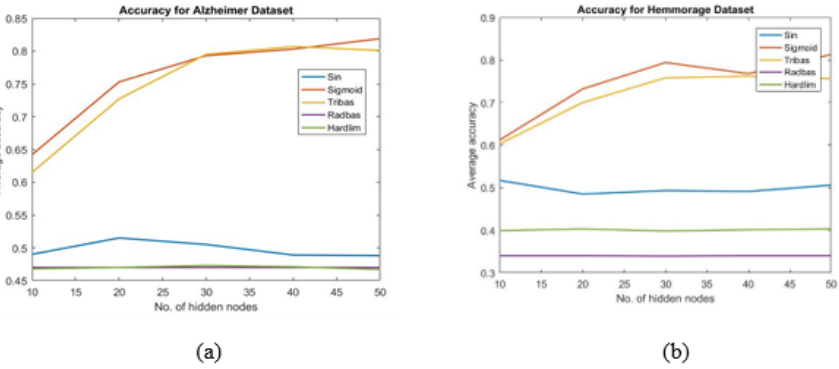
Figure 6. Comparison of average accuracy of five different activation functions along with the number of hidden neurons used in ELM: ( a ) Alzheimer’s dataset and ( b ) Hemorrhage